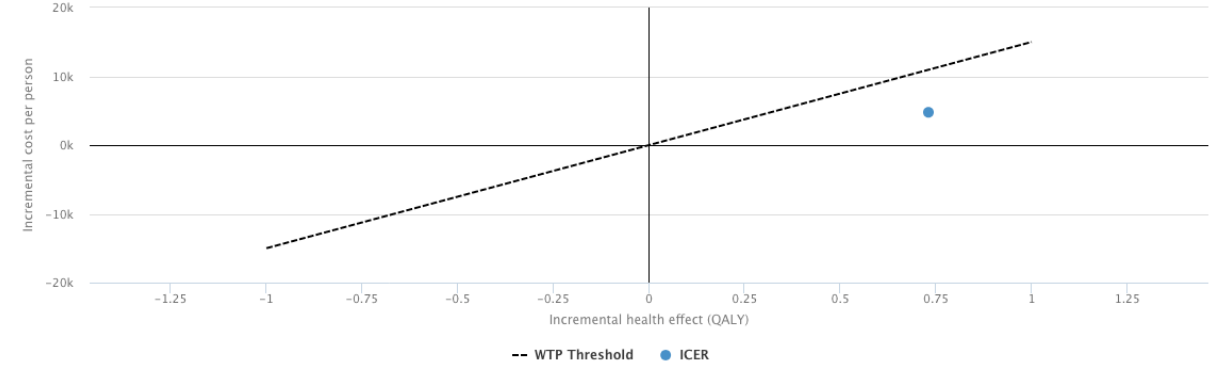
Figure 3. Cost-effectiveness plane for a willingness-to-pay of €15,000 (approximately US $17,481)/quality-adjusted life year. ICER: incremental cost-effectiveness ratio; QALY: quality-adjusted life year; WTP: